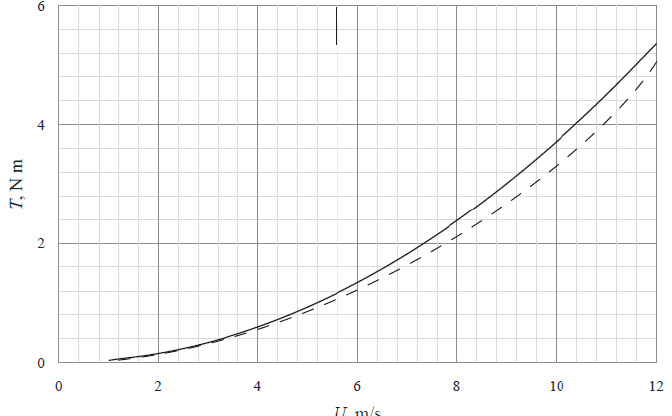
Figure 33. Average starting torque on a stationary three-bladed VAWT as a function of wind